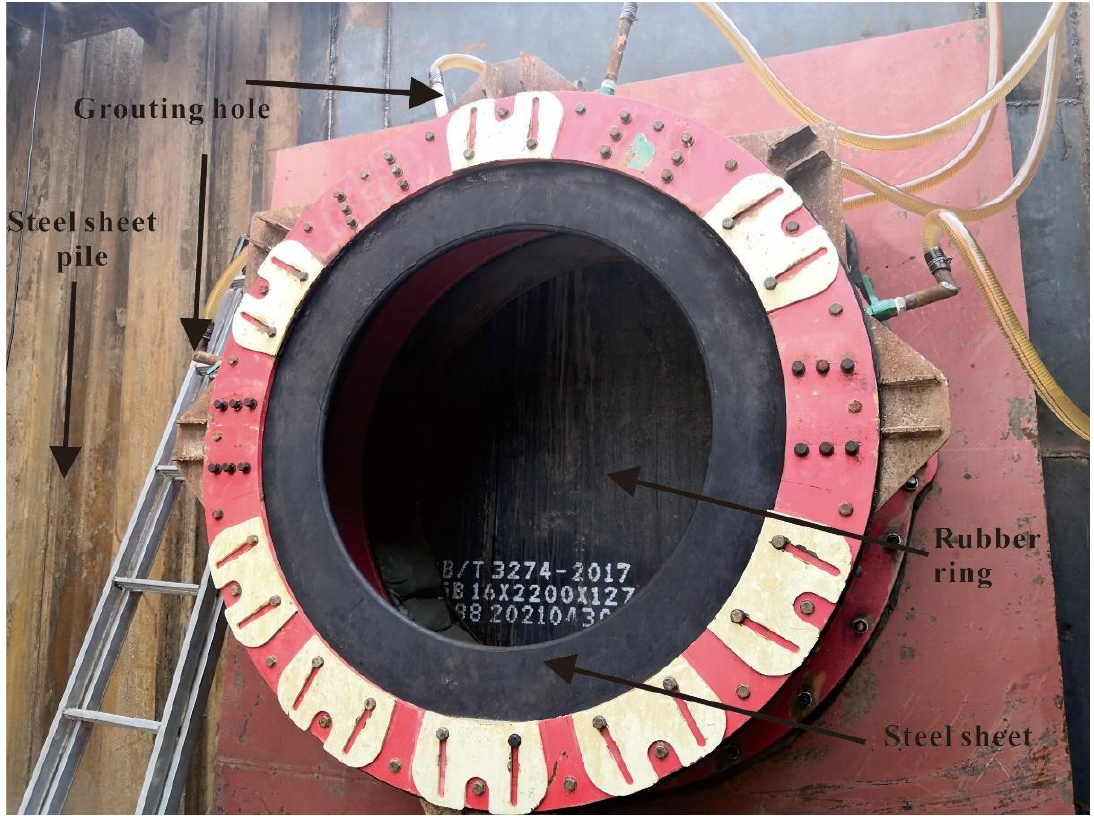
Figure 9. The hole seal of the rapid jacking and pipeline laying method.